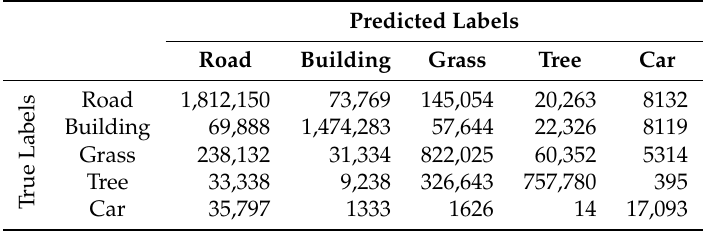
Table 1. Unweighted confusion matrix.